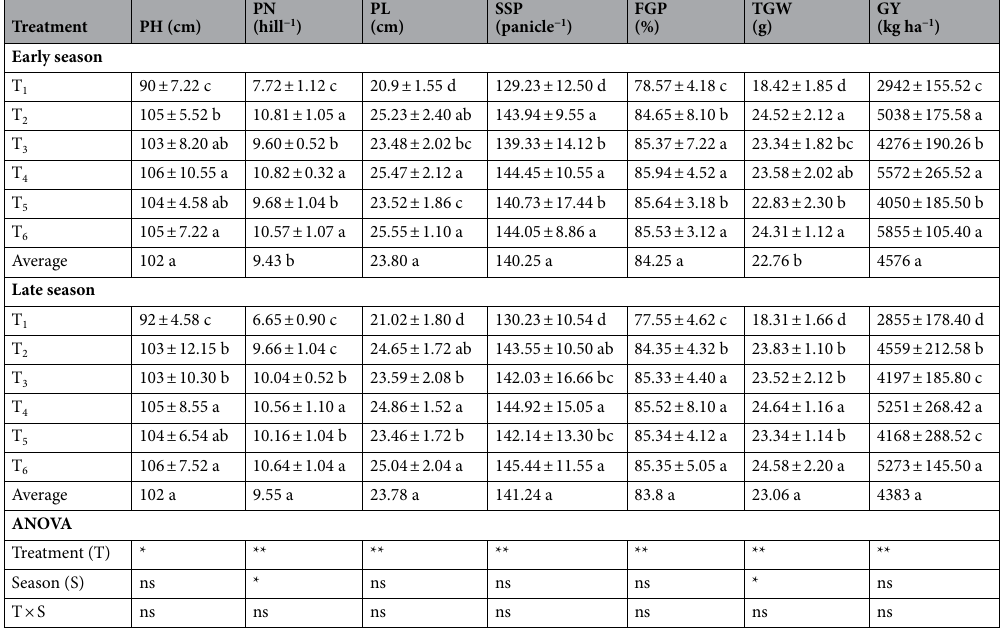
Table 3. Changes in rice growth, yield and yield components under organic and inorganic N fertilizer application. PH plant height, PN panicle number, PL panicle length, SSP spikelet number per panicle, FGP filled grain percent, TGW thousand grain weight, GY grain yield. Values followed by the same letters, within column, are not significantly different at p ≤ 0.05. Mean values (n = 3) ± SE. ns: non significant, * p < 0.05, ** p < 0.05. For treatment details please see Table